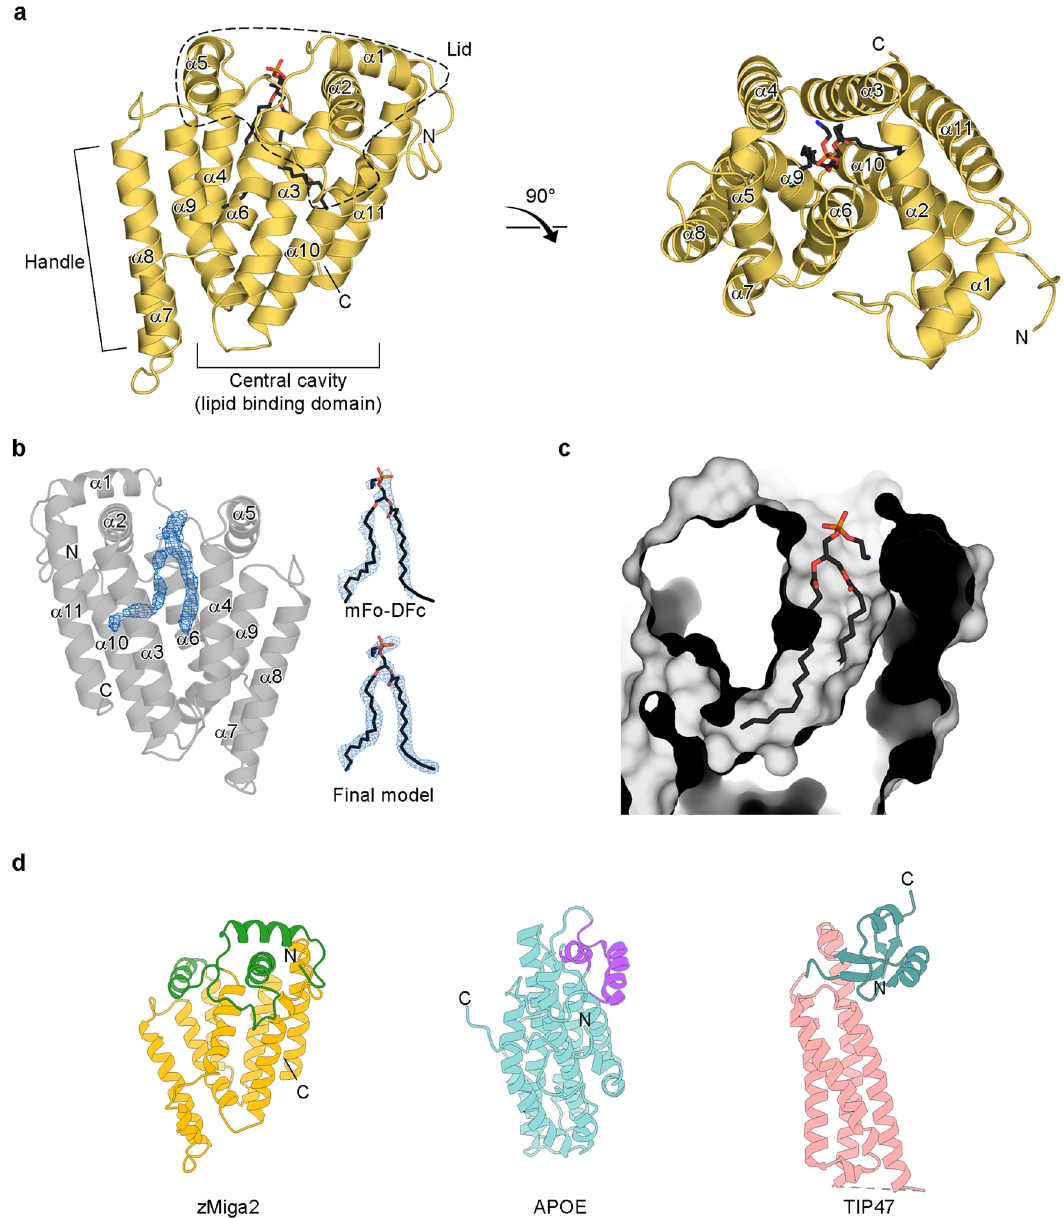
Fig. 2 Overall structure of zMiga2. a Ribbon representation of the zMiga2 (yellow orange). The structure was determined by Se-SAD phasing and re fi ned to 2.85 Å resolution. The overall structure is reminiscent of a mug. The lid is highlighted by dashed lines. The handle protrudes on the left. The black stick model indicates the phospholipid bound to zMiga2. Phosphate, nitrogen, and oxygen atoms are colored in orange, blue, and red, respectively. b The crystal structure of zMiga2 revealed extra electron density (blue, 2.85 Å resolution, contoured at 1.5 σ ), which seemed to be that of a glycerophospholipid (left). Based on the density, we built a PE model with two 16:0 hydrocarbon chains. The fi nal model is shown with the fo-fc map (right top) and 2fo-fc map (right below). The fo-fc map was calculated in the absence of the lipid model and countered at 1.5 σ . The 2fo-fc map is contoured at 0.8 σ . c A protein surface cutaway view shows a large cavity in zMiga2. The structure of PE is shown as a stick representation. d A ribbon diagram shows a structural comparison of lid and helix bundle structure of zMiga2 (lid: green; helix bundle: yellow orange), APOE (lid: purple; helix bundle: cyan) (PDB ID: 2L7B), and TIP47 (lid: teal; helix bundle: pink) (PDB ID: